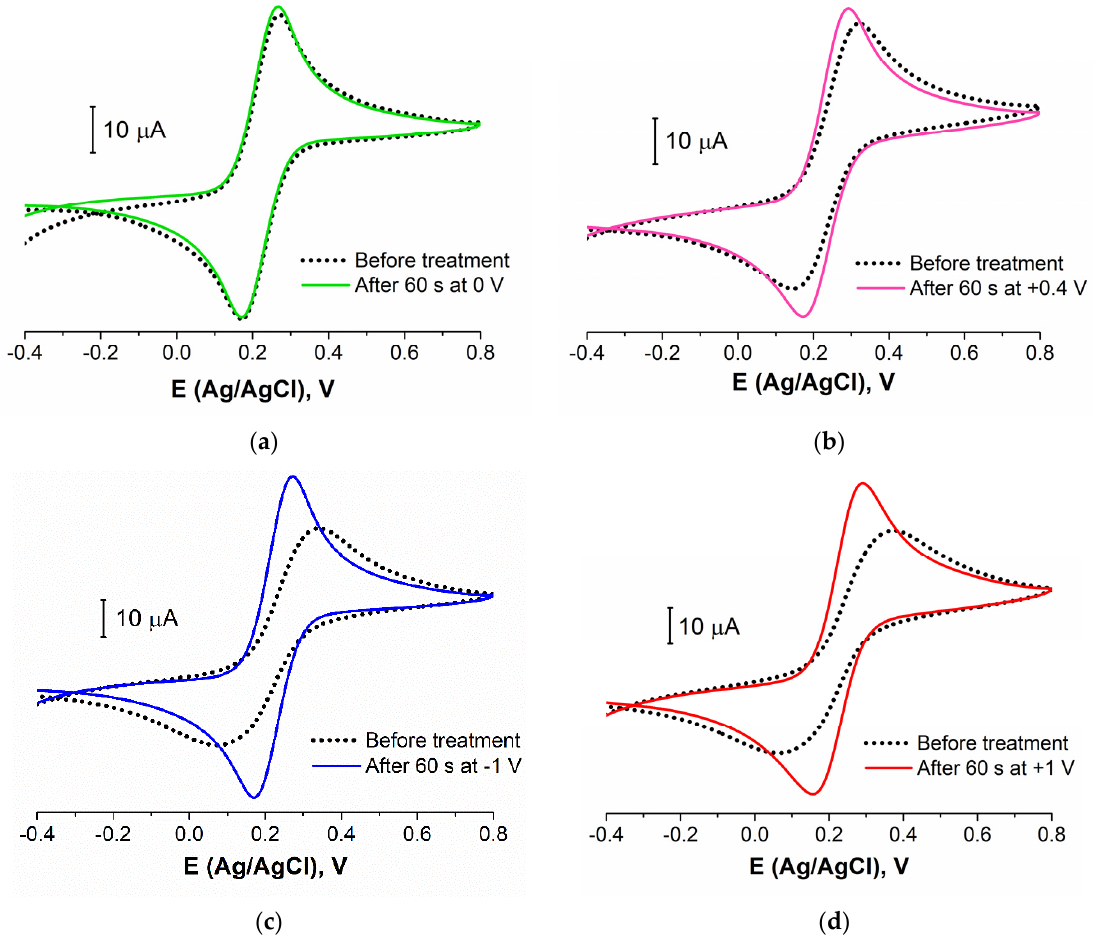
Figure 5. CVs for aptasensor (Au disc/LC-18) before (black dotted curve) and after (colored curves) potentiostatic treatment at: ( a ) 0 V; ( b ) +0.4 V; ( c ) –1 V; ( d ) +1 V. Solution: 0.025 M K 3/4 [Fe(CN) 6 ] in PBS (7.4).